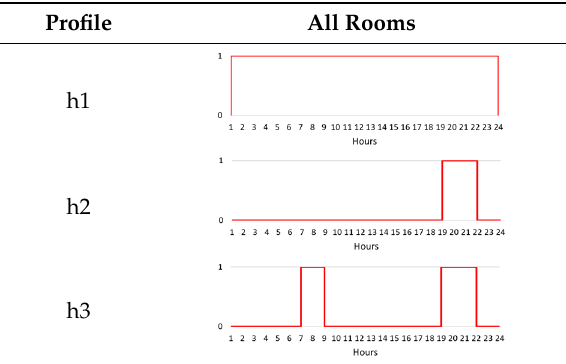
Table 2. Daily heating schedules (On = 1, Off = 0).